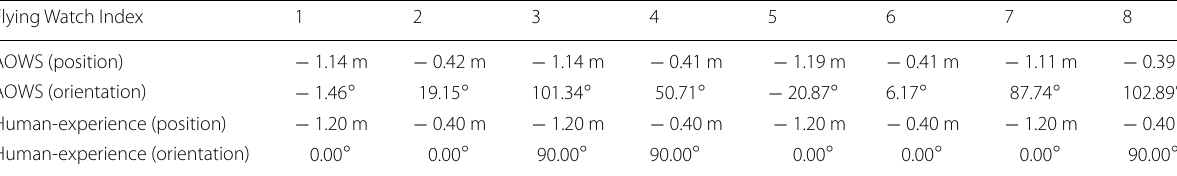
Table 1 Aows-based and human-experience-based allocations of static mission Flying Watch Index